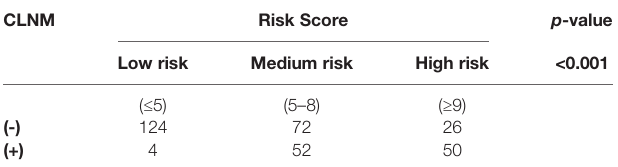
TABLE 5 | Validation group